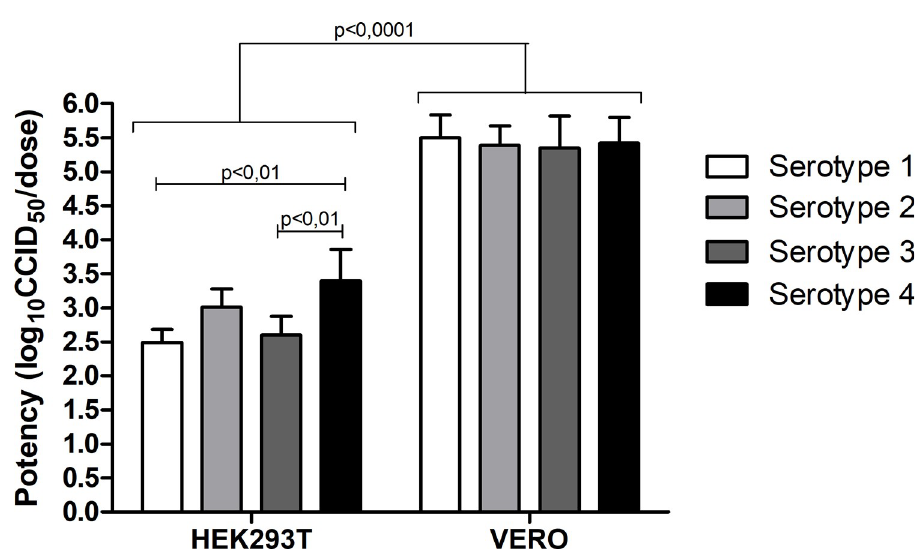
Fig 4. Comparison of the infectivity of the four distinct DENV serotypes in VERO and HEK293T cells. CCID 50 (mean ± SD) of each serotype measured by immunocolorimetric assay after 7 days of infection. Two-Way ANOVA performed for group comparison and significant differences observed among cell types (p < 0.0001) and serotypes 4 and 3 (p < 0.01) and serotypes 4 and 1 (p < 0.01) measured in HEK293T cells. No significance detected in VERO cell groups. n =